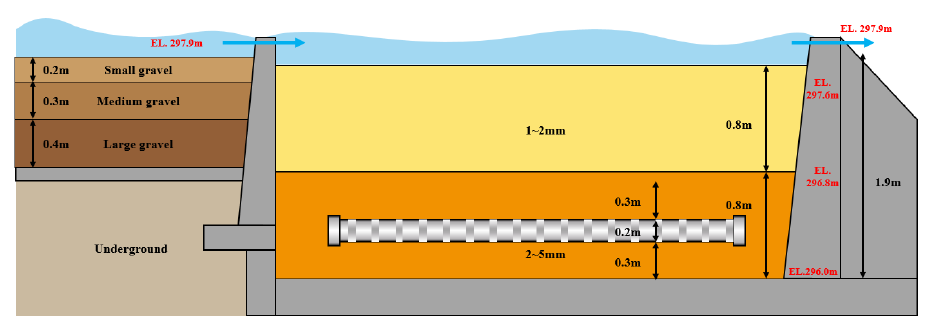
Figure 3. Cross section of existing intake reservoir (pond) and sand dam.